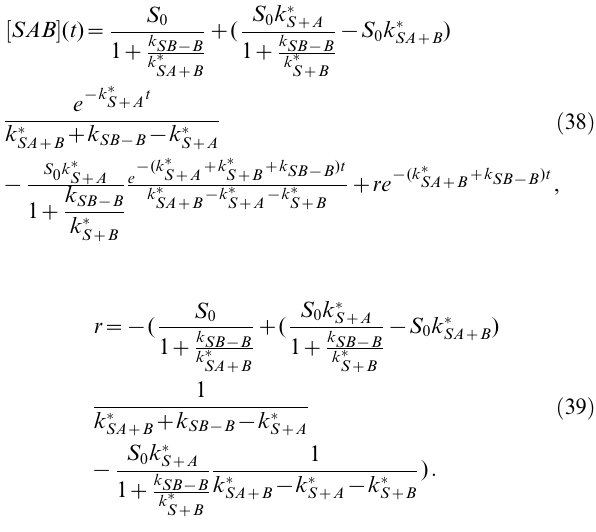
models with the addition of a new feature, which can be seen in Figure 4. In contrast to the previous models, the recruitment curves of this model have a maximum that is larger than the plateau value if k S z B w k SA z B and k SB { B w 0 . The reason for this 2 the association and dissocia- feature is that at t & z k k (cid:3) SB { B S z B tion of B are equilibrated. But, since the concentration of recruited A still increases, which in turn decreases the association rate of B , the equilibrium of B is shifted downwards. Interestingly the curve with the lowest B 0 shows the highest peak, which can be explained by its lower asymptotic concentration at t ~ ? , to which the curves were normalized. If k S z B v k SA z B and k SB { B w 0 , this can lead to an initial increase of the slope similar to the one observed in the previous model with k S z B v k SA z B and k SB { B ~ 0 . But, if k S z B v k SA z B